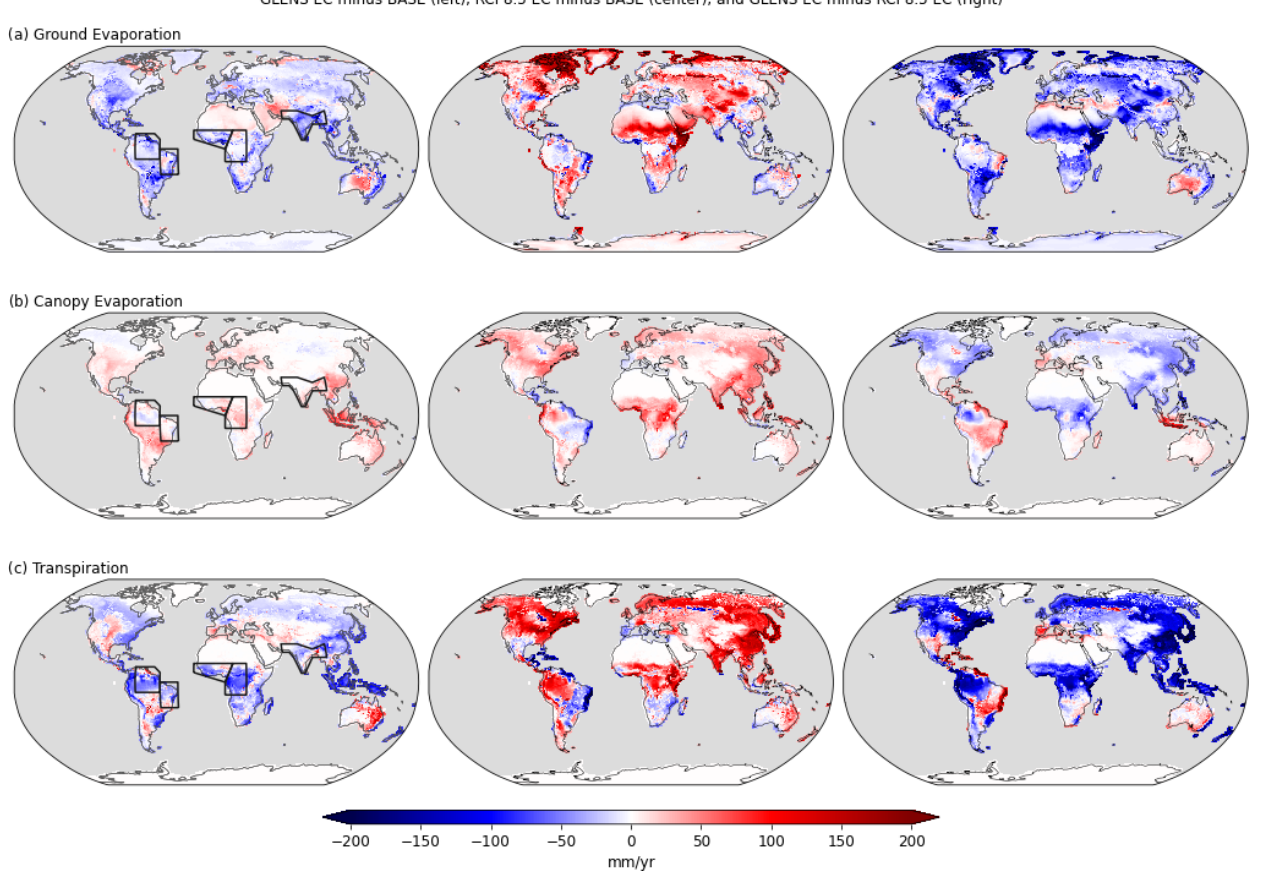
Figure 11. Projected changes between GLENS EC (2075–2095) and BASE (2010–2030) in the left column, changes between RCP8.5 EC (2075–2095) and BASE (2010–2030) in the center column, and changes between GLENS EC (2075–2095) and RCP8.5 EC (2075–2095) in the right column in (a) ground evaporation, (b) canopy evaporation, and (c) transpiration. Highlighted regions in the left column are as for Fig.